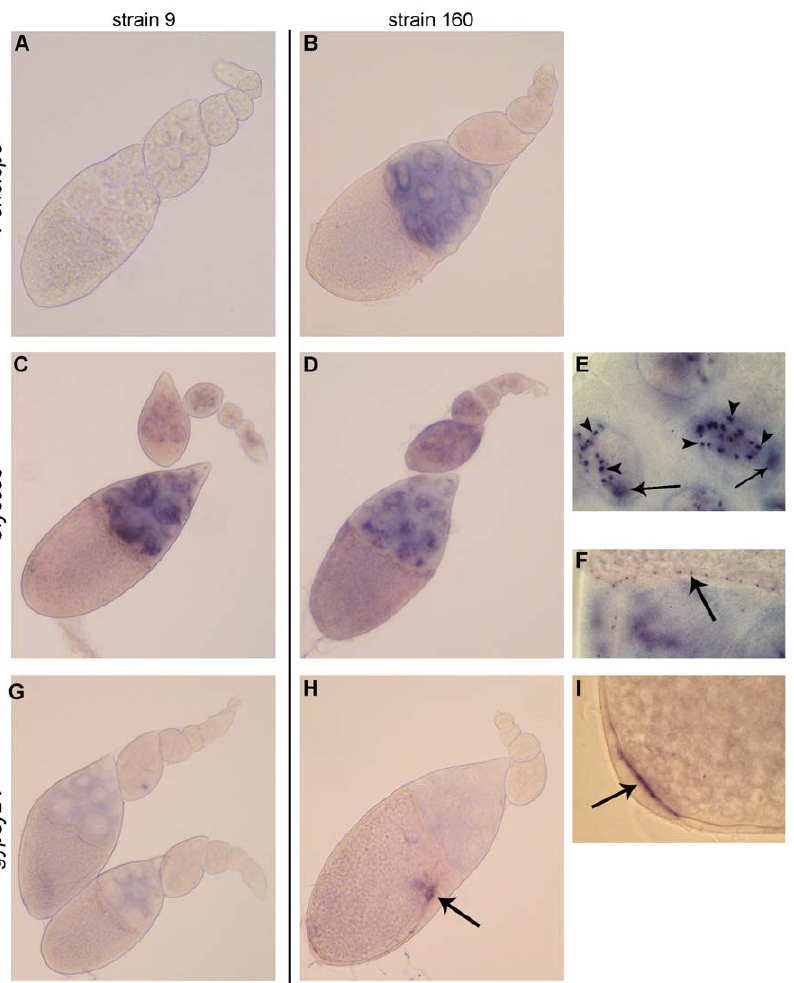
Figure 2. Whole-mount insitu RNA detection of sense transcripts of Penelope , Ulysses and gypsyDv in the ovaries of D.virilis strains 9 and 160. (A) and (B) hybridization with Penelope -specific probe. No hybridization is seen in strain 9 (A), while in strain 160 (B) strong hybridization in the nurse cells cytoplasm is evident at stage 10. Ulysses -specific probe strongly hybridized with nurse cells nuclei in both strains at stages 2–10 (C, D, E). Arrows in E indicate putative RNA processing sites (foci), arrow-heads indicate putative nascent transcripts. Heavier label accumulation is usually observed in the cytoplasm of nurse cells of strain 9 (C). Reproducible hybridization of Ulysses probe with the centripetal (see arrow in F) and stretched follicle cells is a characteristic feature of strain 9 and 160 ovaries at stage 10. RNA in situ hybridization with gypsyDv -specific probe reveals hardly detectable labeling in the nurse cells cytoplasm in the ovaries of both strains studied (G–I). Significant hybridization of gypsyDv probe with follicle cells, which form appendages (H) and with follicle cells at the posterior end of ovarian chamber (I) represent the landmarks of strain 160. detailed analysis of small RNAs homologous to the retroelements studied.